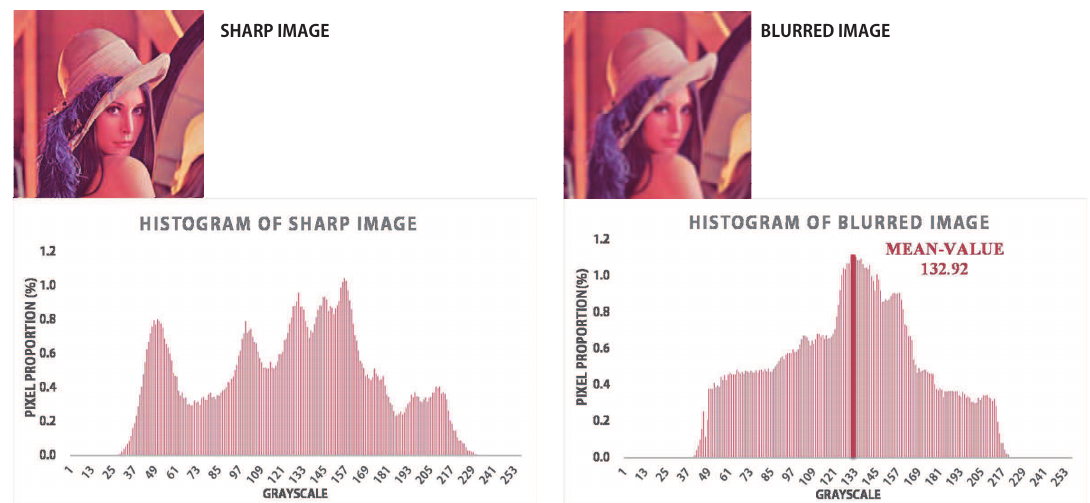
Figure 4. Sharp ( left ) and Gaussian blurred ( right ) images with their grayscale histograms.